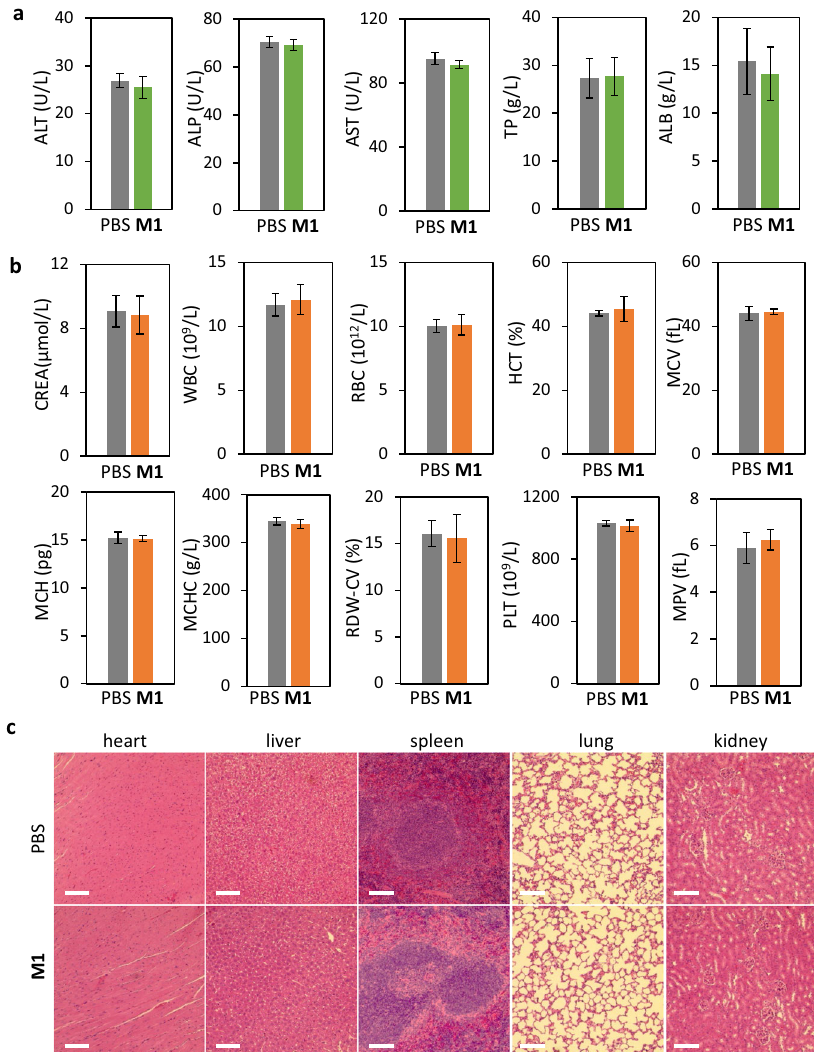
Fig. 8 Acute toxicity evaluation. a Liver function indicators: alanine aminotransferase (ALT), alkaline phosphatase (ALP), aspartate aminotransferase (AST), total protein (TP) and albumin concentration (ALB). The mean of four biological replicates is shown and data are presented as mean values± SD ( n = 4). b Blood biochemical indicators: creatinine (CREA), white blood cells (WBC), red blood cells (RBC), hematocrit (HCT), mean corpuscular volume (WCV), mean corpuscular haemoglobin concentration (MCH), mean corpuscular hemoglobin concentration (MCHC), red cell volume distribution width- coef fi cient of variation (RDW-CV), platelet (PLT)and mean platelet volume (MPV). The mean of four biological replicates is shown and data are presented as mean values ± SD ( n = 4). c Histologic sections of different organs: heart, liver, spleen, lung, kidney and pancreas compared with healthy group (PBS). Staining: H&E; Injection dose of M1. (i.v. administration): 16 mg/kg; Administration time: 24 h. Scale bar 200 μ